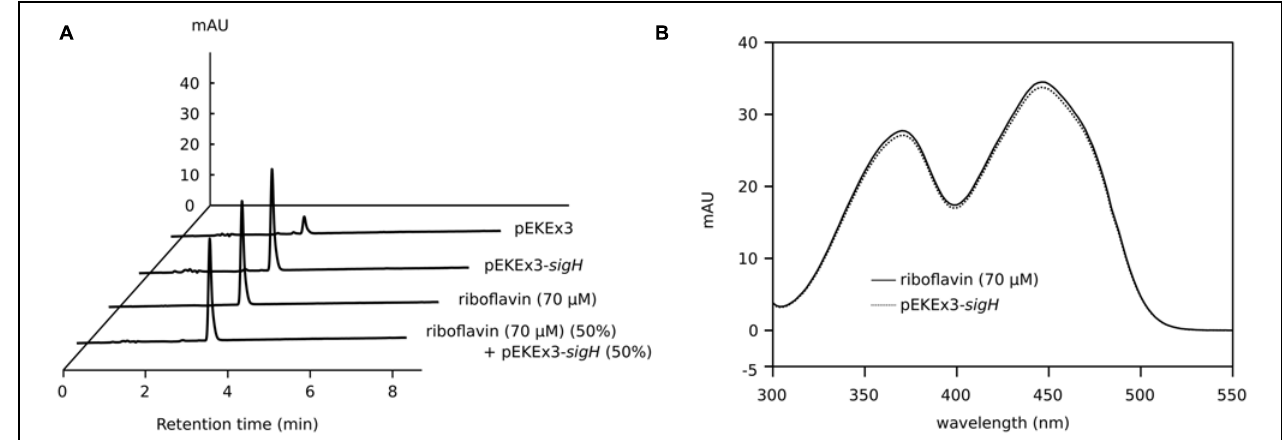
IPTG at the start of the cultivation. A standard of pure riboflavin (70 μ M) and a 50%/50% mixture of this standard and the supernatant of the culture of WT(pEKEx3- sigH ) are given for comparison. Absorbance at 450 nm is shown. (B) Spectra recorded at the retention time of 3.2 min of the HPLC samples of